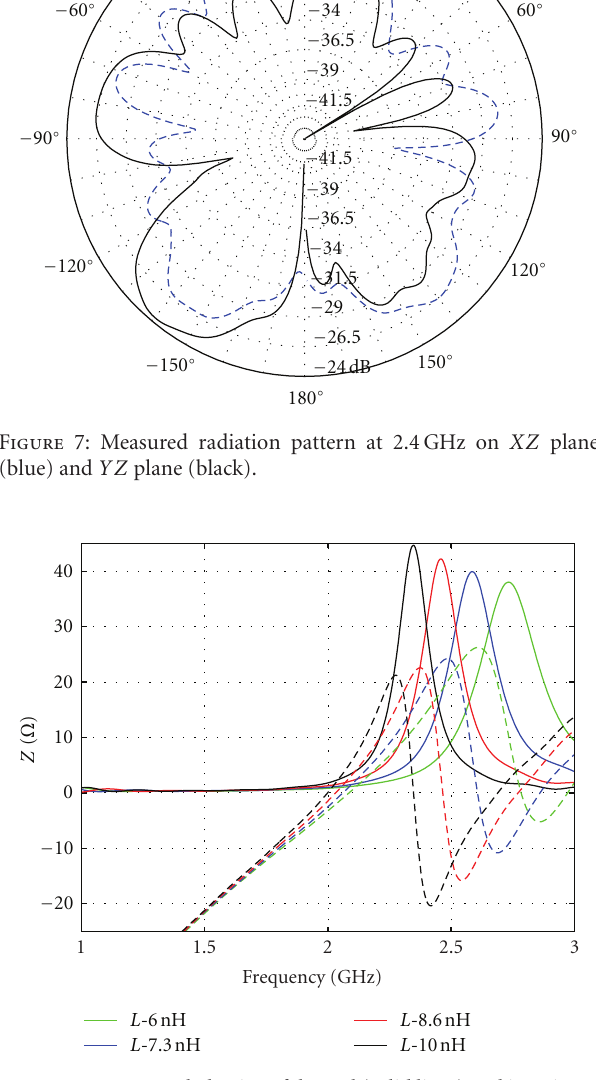
Figure 8: Frequency behavior of the real (solid lines) and imaginary (dashed lines) part of the antenna input impedance versus the inductance values of the chip